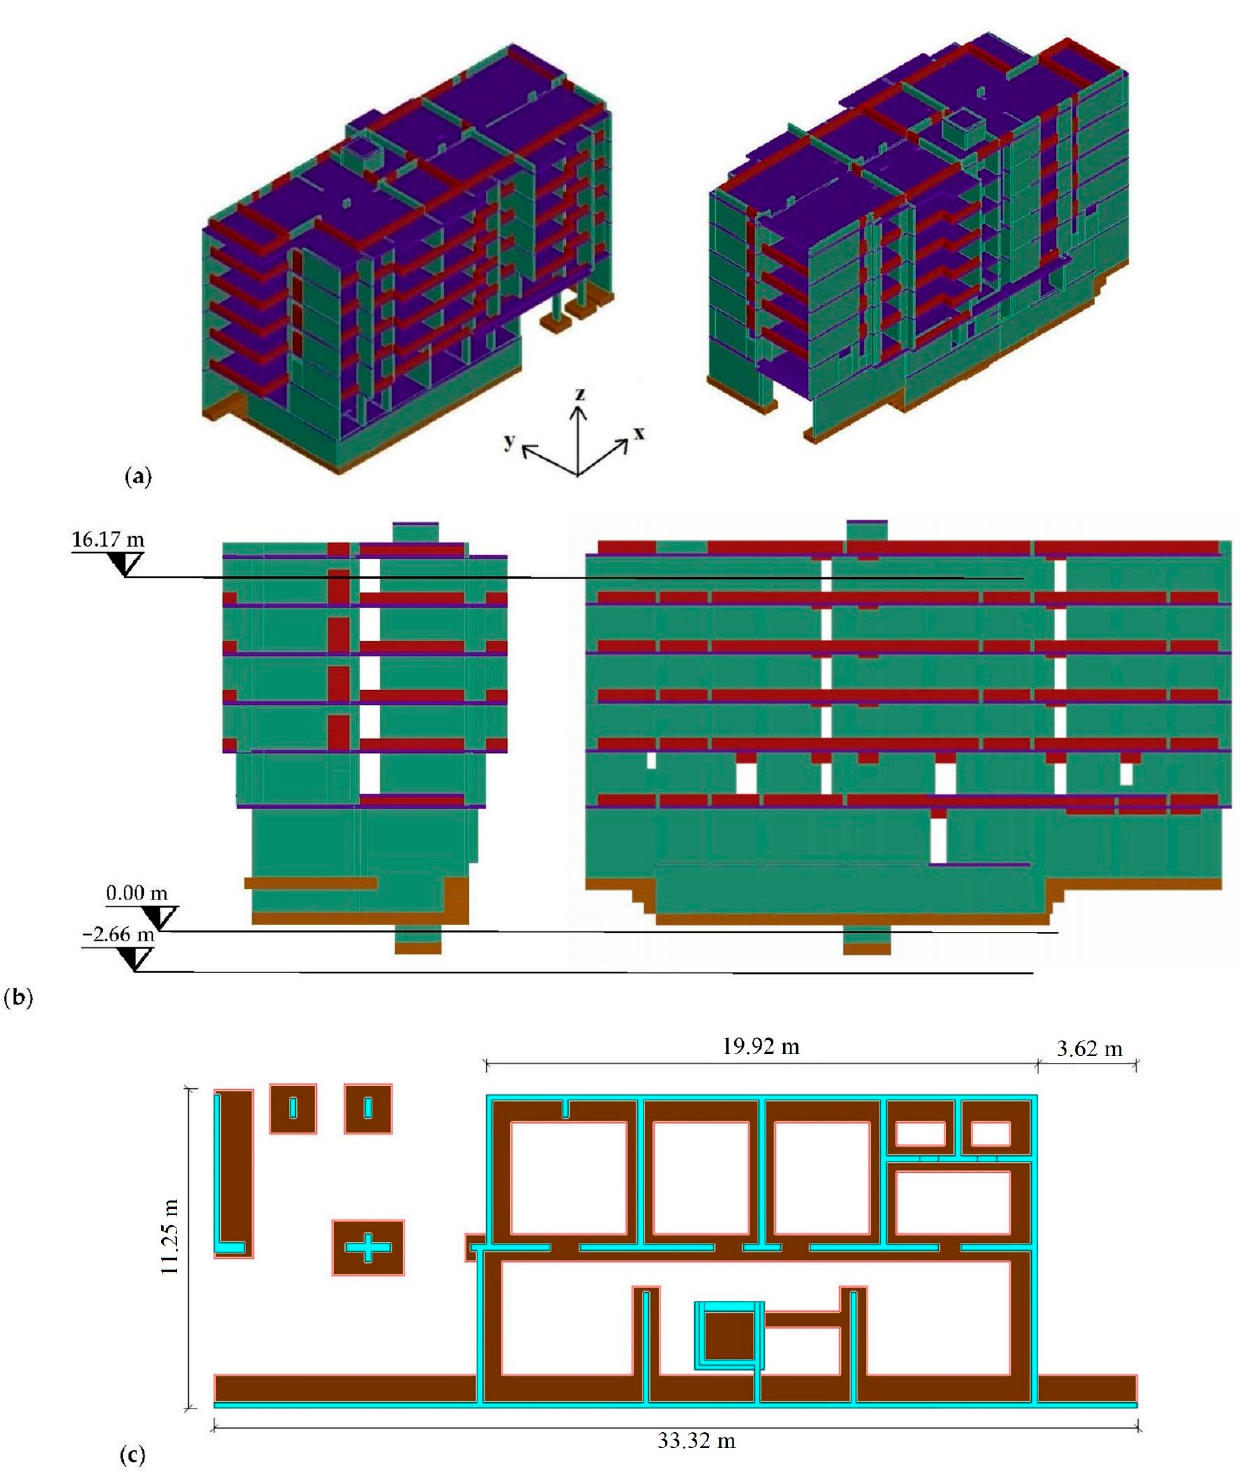
Figure 3. Overall views with the different structural components: ( a ) 3D rendering views; ( b ) elevation sections, and ( c ) plan of the building . Shear walls and upturned beams are colored in green and red, respectively.